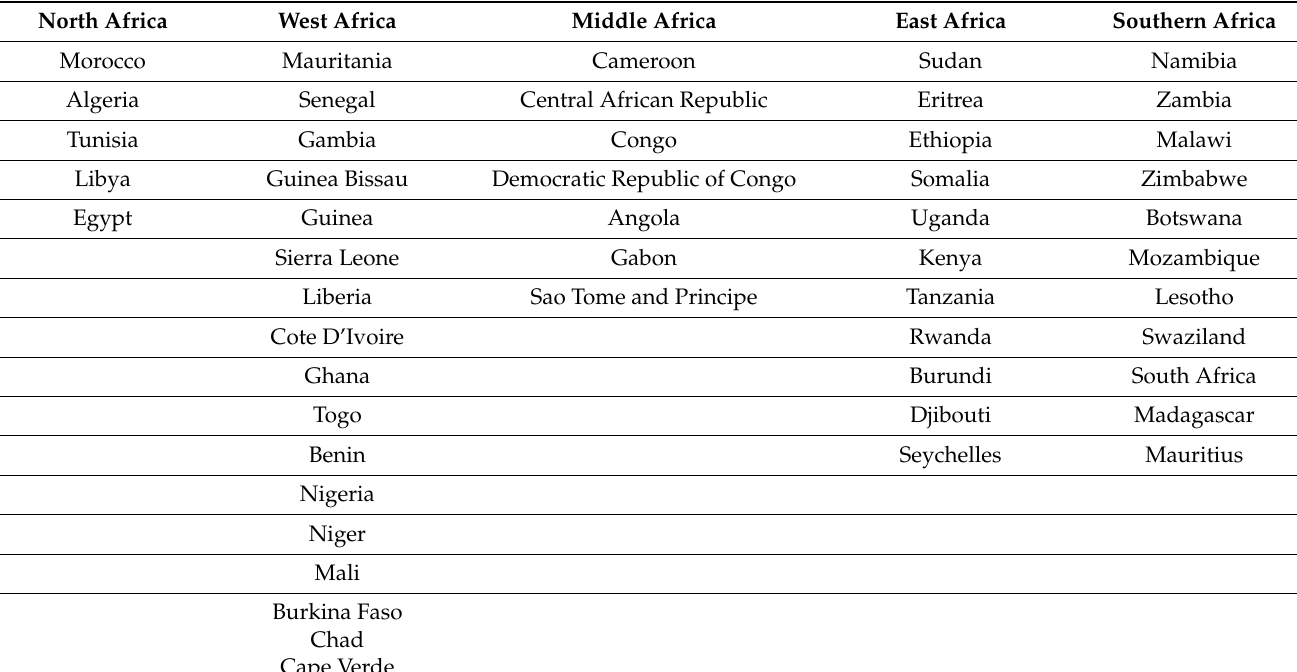
Table 1. Countries included in the data